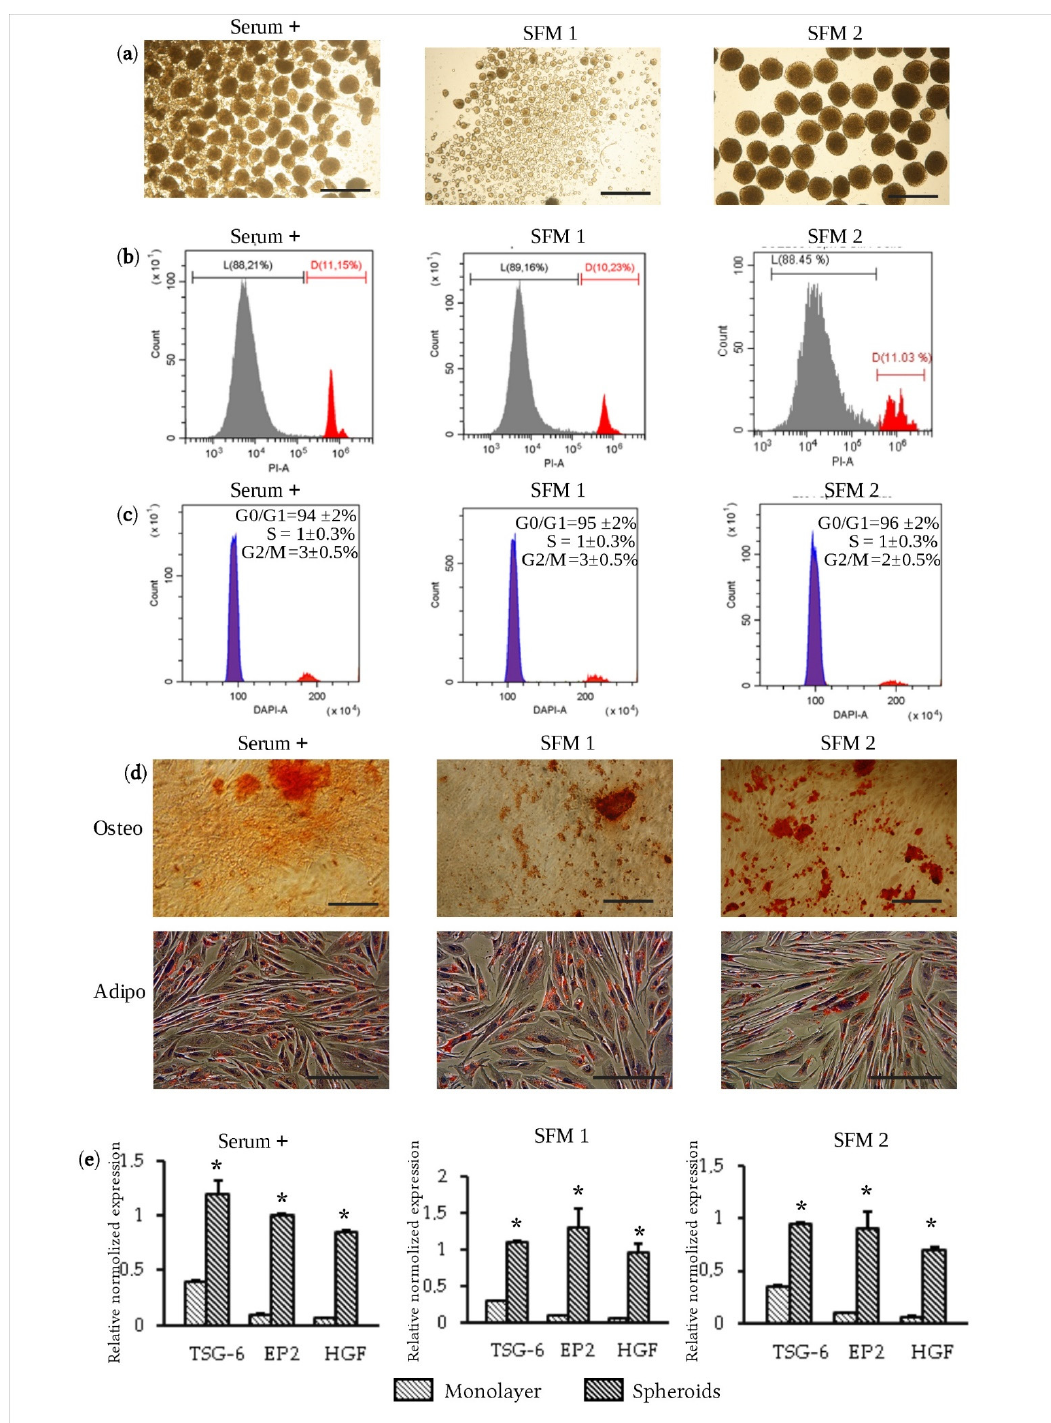
Figure 2. Viability, multipotency, cell cycle distribution and gene expression of eMSC spheroids under serum-free conditions. ( a ) Aggregation of eMSCs into spheroids cultured in serum-containing medium (Serum+), SFM 1 or SFM 2 (scale bar, 300 µ m.); ( b ) viability of eMSCs in spheroids cultured in serum-containing medium (Serum+), SFM 1 or SFM 2; L—live cells, D—dead cells; ( c ) representative cell cycle distribution of eMSCs in spheroids cultured in serum-containing medium (Serum+), SFM 1 or SFM 2. ( d ) Osteogenic and adipogenic differentiation of eMSCs in spheroids cultured in serum- containing medium (Serum+), SFM 1 or SFM 2 (scale bar, 200 µ m). ( e ) q-RT-PCR assay of TSG6, EP2 and HSF genes in eMSC spheroids and monolayer cells under serum-free conditions. Data are shown as mean ± SD ( n = 3). Two-tailed Student’s t-test was utilized for pairwise comparison. * p < 0.01 vs. eMSCs in